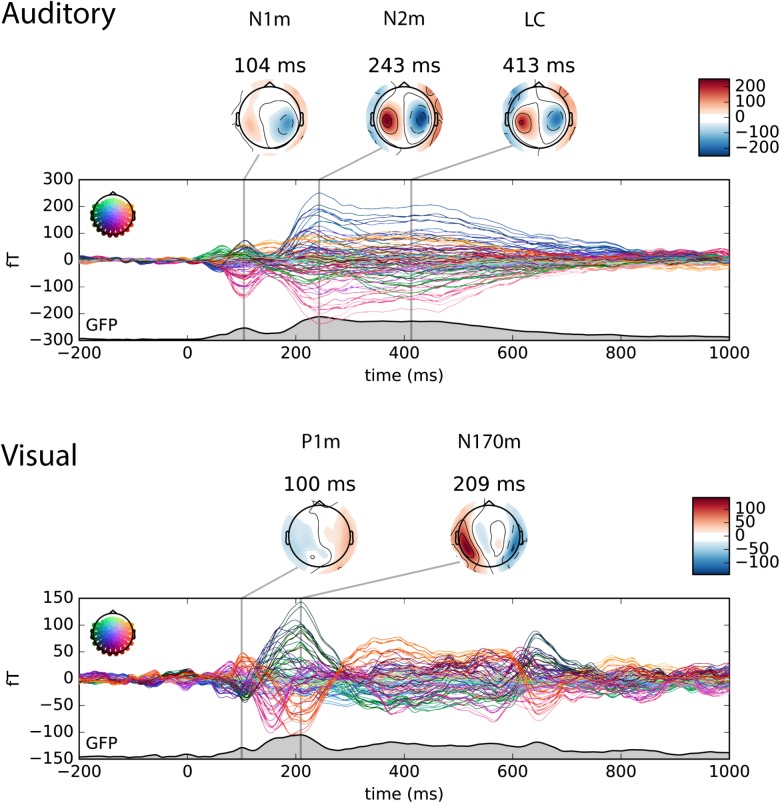
Butterfly plot of the magnetometer channels in the auditory only (upper panel) and the visual only (lower panel) conditions. The individual waveforms are colored by its position in the sensor array as shown on the upper left in each panel. The topography plot shows the auditory N1m, N2m and late component (LC) in the auditory only condition and the visual P1m and N170m in the visual only condition at the local maximum of the global field power (GFP).